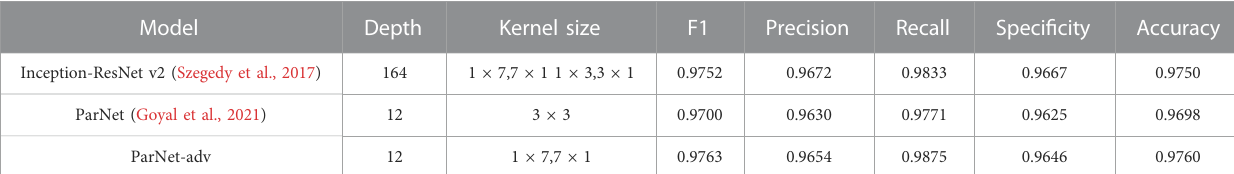
TABLE 4 Comparison of AF detection based on different models.